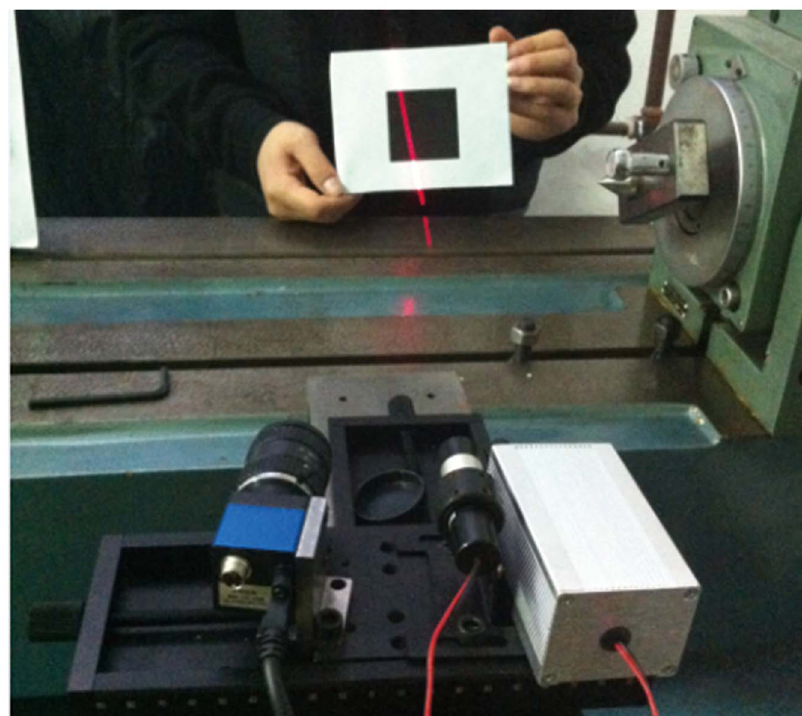
Figure 4. Calibration using the planar target.